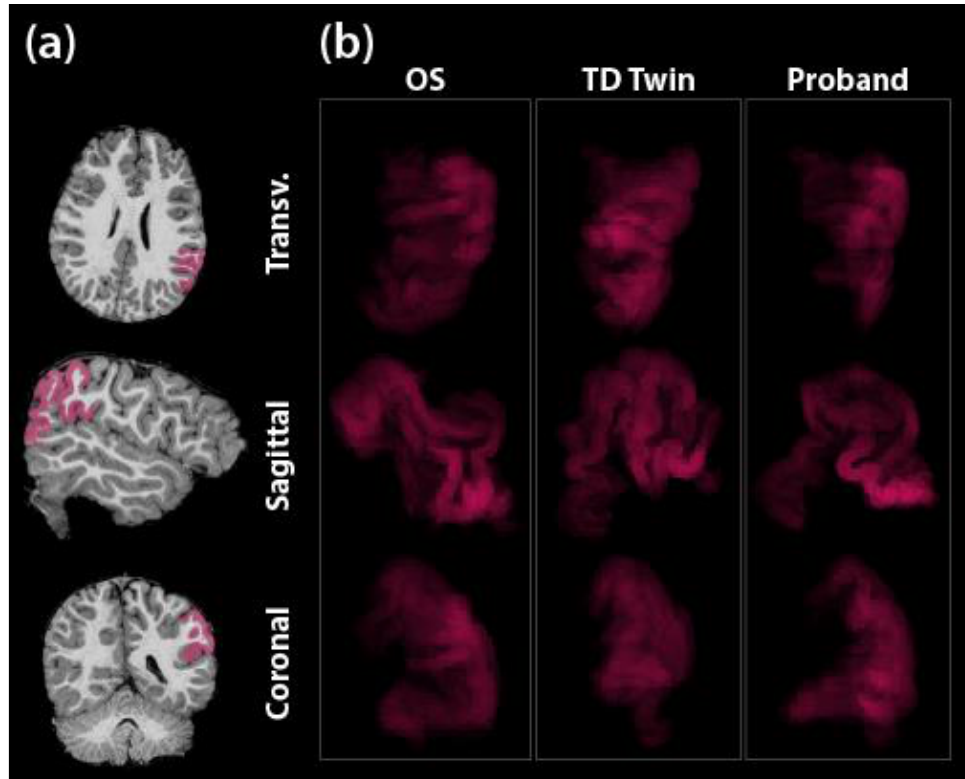
Figure 1. Composite images constructed from the MRI data for the supramarginal gyrus. ( a ) Masked areas are superimposed over anatomy in Freesurfer, on left. ( b ) Composite images constructed from layering many such masks are shown on the right. Each column shows the composite images of one sibling: the older sibling (OS) and the twins (TD Twin and Proband), respectively; rows represent the three anatomic axes. Images are semi-transparent such that brighter areas indicate higher volume areas—or more precisely, a brighter pixel is one that was present in a greater number of mask slices. Colorization is arbitrary and is used in masking to visually differentiate the mask from the underlying grayscale MRI image; grayscale versions were used in analysis.